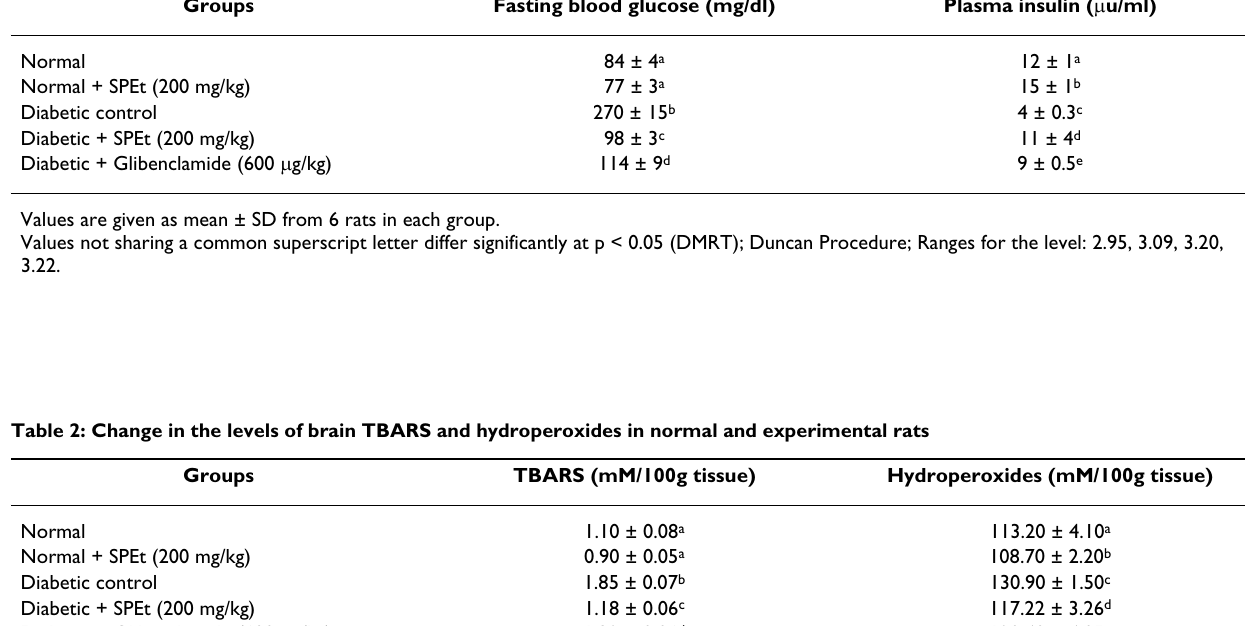
Table 1: Effect of Scoparia dulcis on blood glucose and plasma insulin in normal and experimental rats Groups